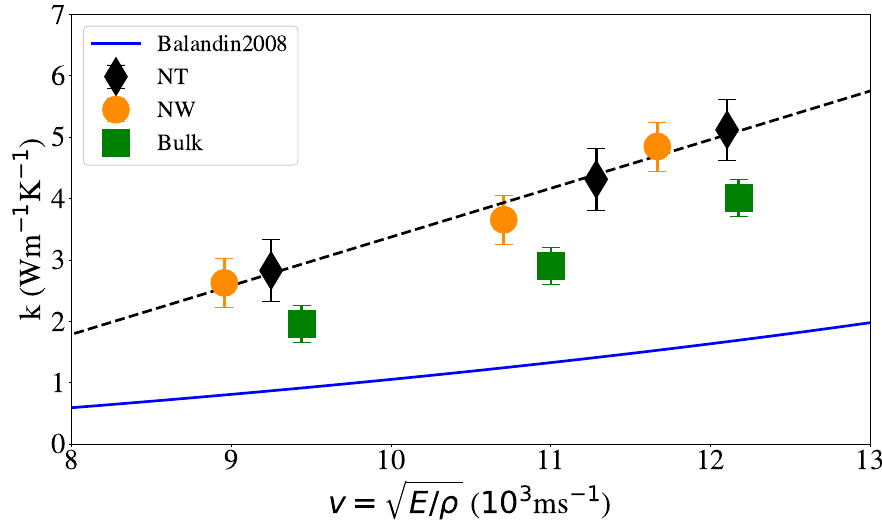
(cid:112) E / ρ for different geometries (NT